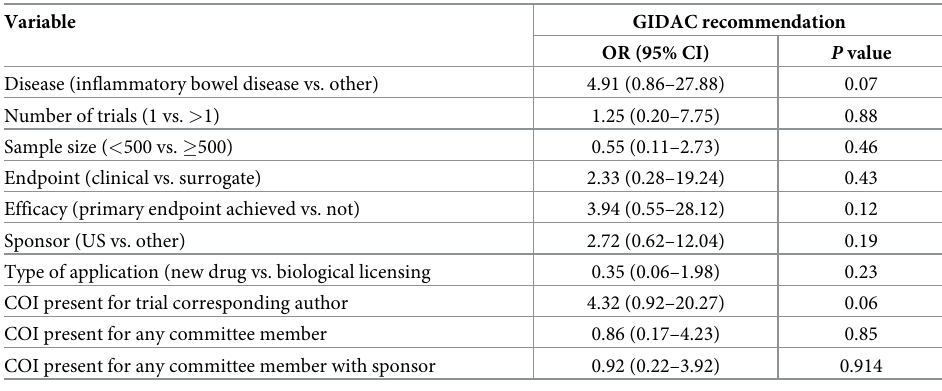
Table 5. Predictors of receiving a GIDAC recommendation.